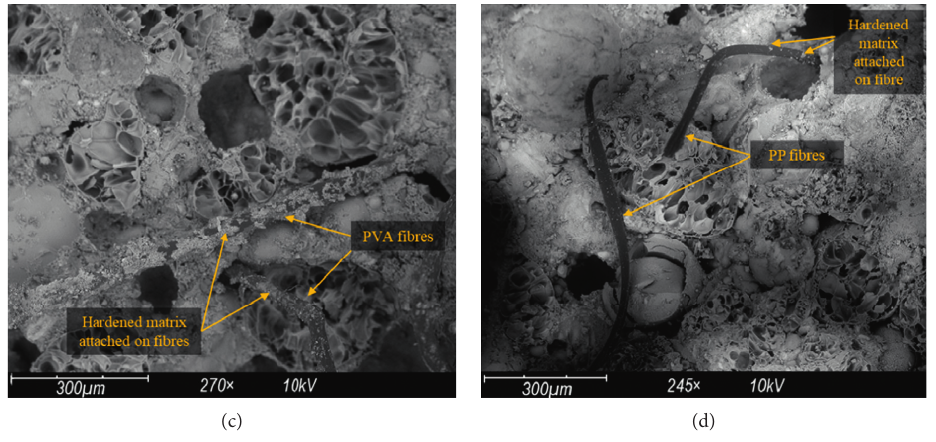
Figure 8: SEM images of (a) control mix; (b) LCC-basalt; (c) LCC-PVA; (d) LCC-PP.